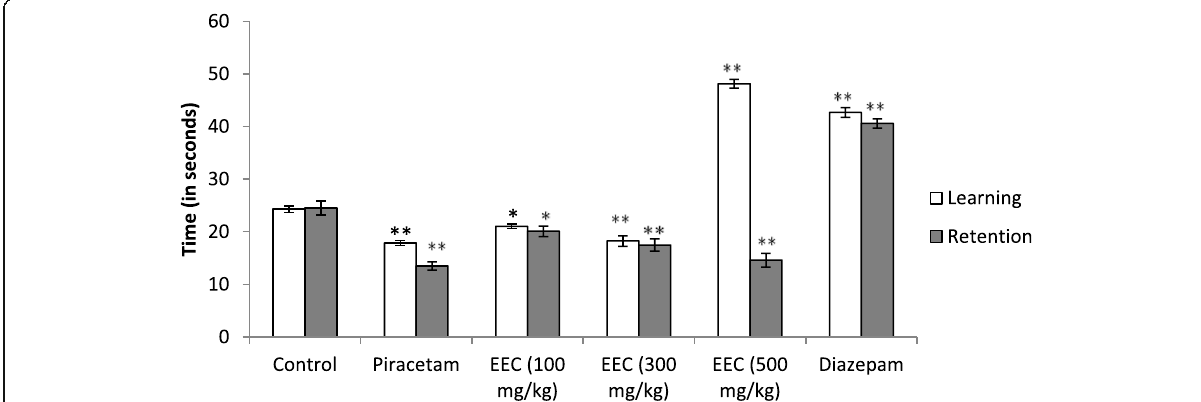
Fig. 1 Effect of EEC on transfer latency (TL) using elevated plus maze model. All values are mean ± SEM (n = number of animals in each group). Data was analyzed using one-way ANOVA followed by Dunnett test. *** p < 0.001, ** p < 0.01 and * p < 0.05 vs. normal control